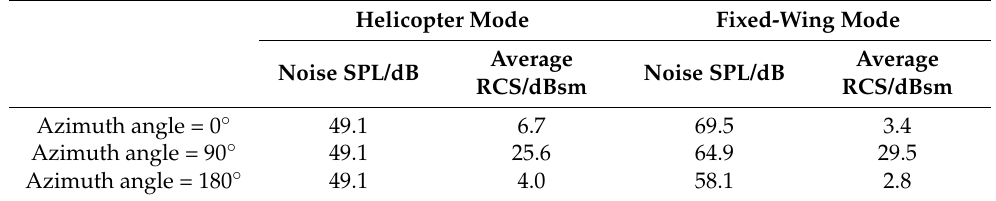
Table 20. Noise SPL and average RCS values with